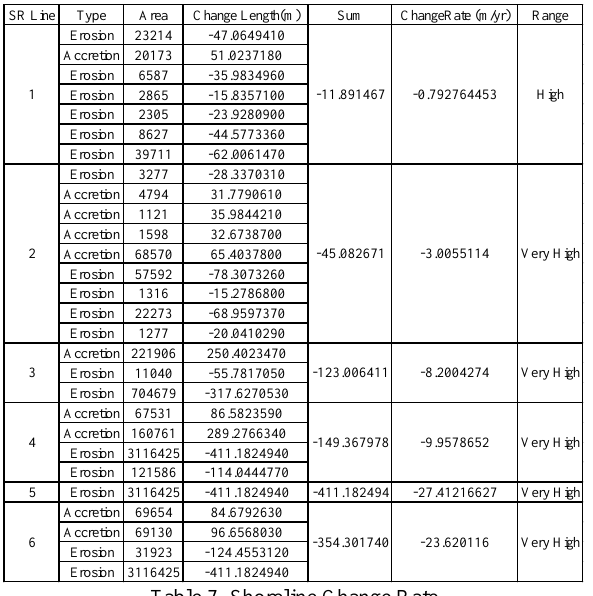
Table 7. Shoreline Change Rate Table 8 below show data for coastal slope for each six MU. Data for coastal slope are getting from measuring slope using Google Earth. MU-1 and MU-3 represent High rank and MU-4 and MU-2 are in very low rank.